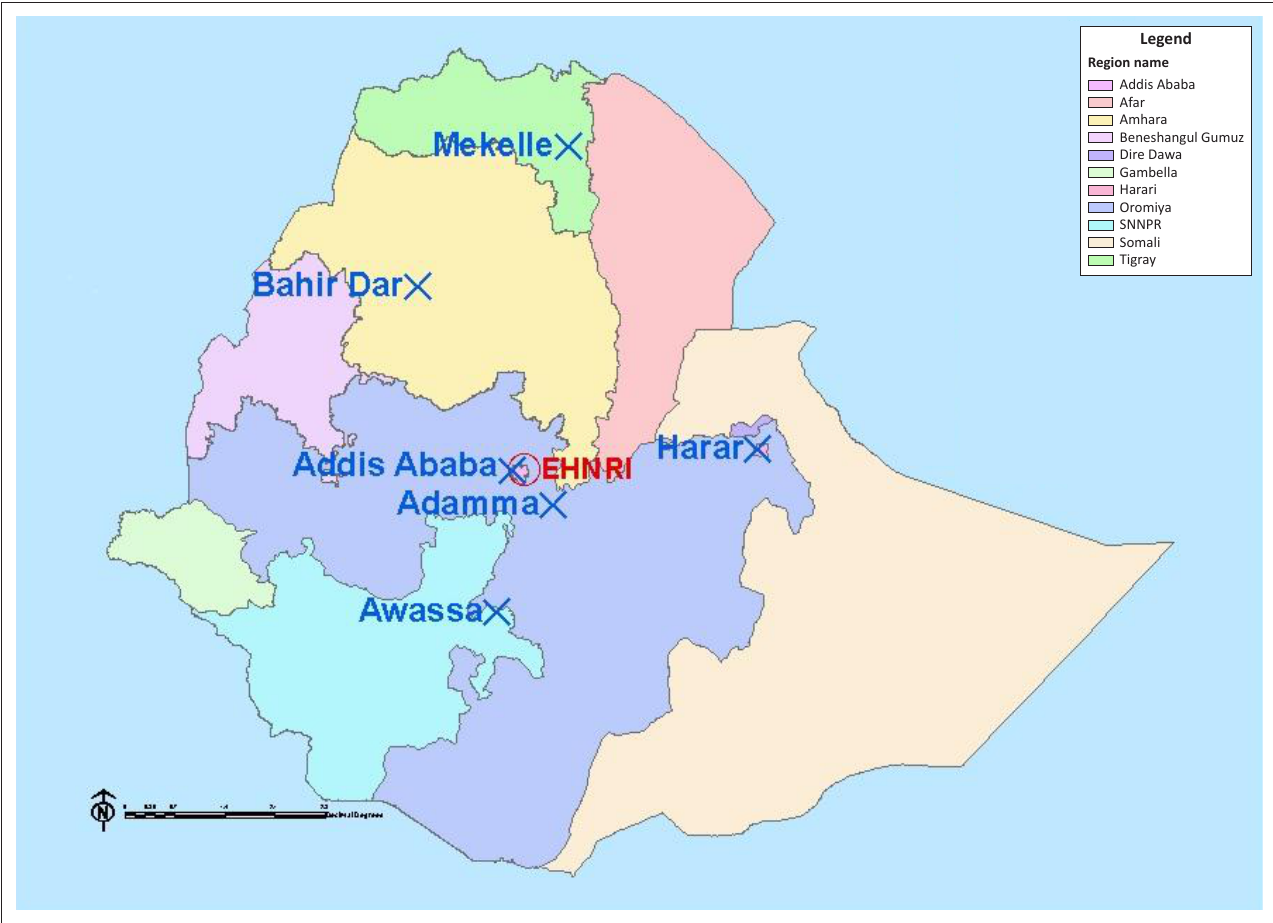
Rollout of DNA polymerase chain reaction facilities for early infant diagnosis to regions in Ethiopia. Circle in blue denotes national HIV reference laboratory at the Ethiopian Health and Nutrition Research Institute in Addis Ababa where early HIV infant diagnosis (EID) started in 2006. Crosses in blue denote location of new sites with names in red and their regions (in black) where EID testing occurred following rollout in 2008. Harar site is for Harari region. SNNPR represents Southern Nations, Nationalities and People’s region. FIGURE 2: Regionalisation of early infant diagnosis